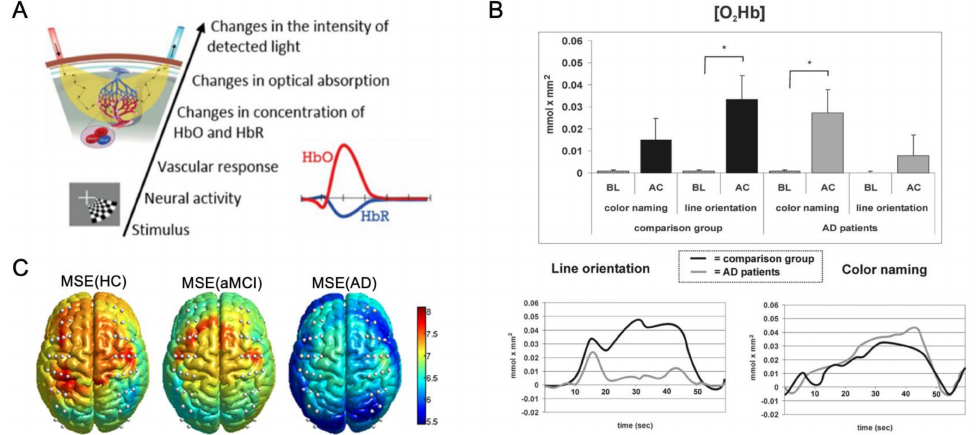
Figure 5. fNIRS imaging. ( A ) Schematic diagram of functional near-infrared spectroscopy (fNIRS) system. Adapted from [85] with permission from Elsevier. ( B ) Average increase in O2Hb during the baseline (BL) and activation phase (AC) for AD and comparison groups in the line orientation task. * P <0.05. Adapted from [86] with permission from Elsevier. ( C ) Brain activation represented by spatial maps of multiscale entropy (MSE) analysis in HC, aMCI, and AD groups. Adapted from [89] with permission from OSA Publishing